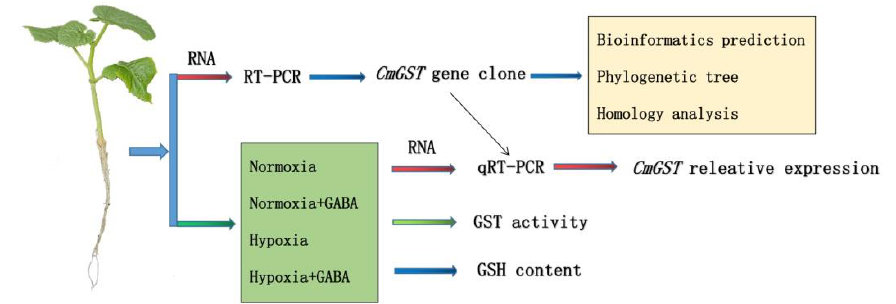
Figure 1. Technology roadmap .